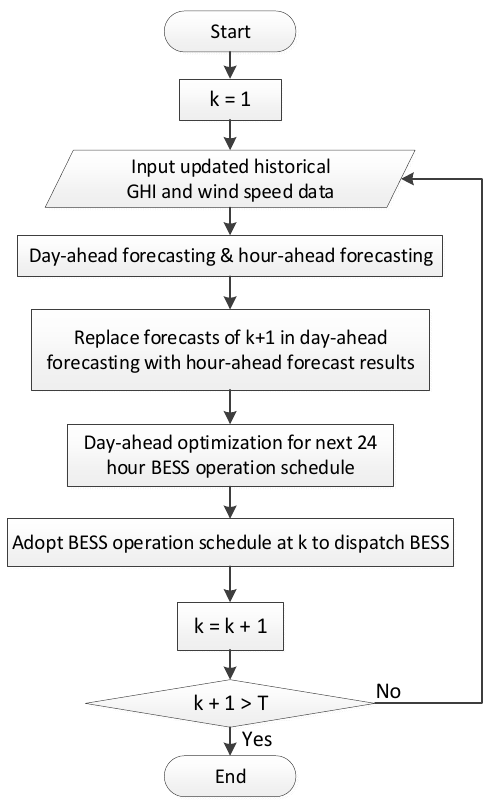
Figure 4. The Flow Chart of the Mixed RHC Optimisation Strategy.